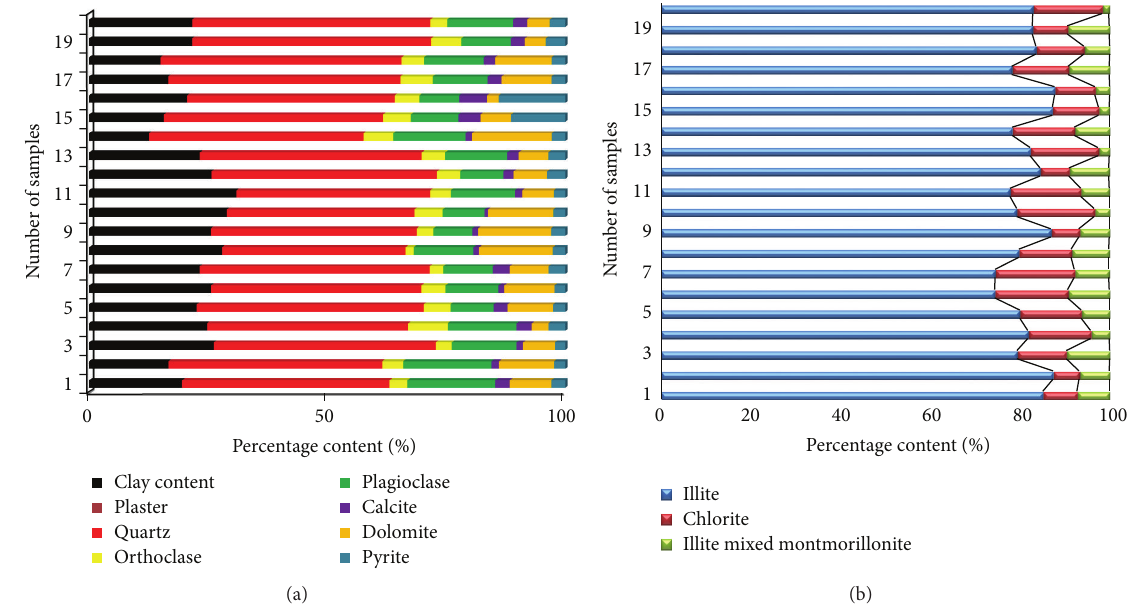
Figure 2: Analysis of mineral composition: (a) the relative contents of minerals in the composition; (b) clay mineral content.